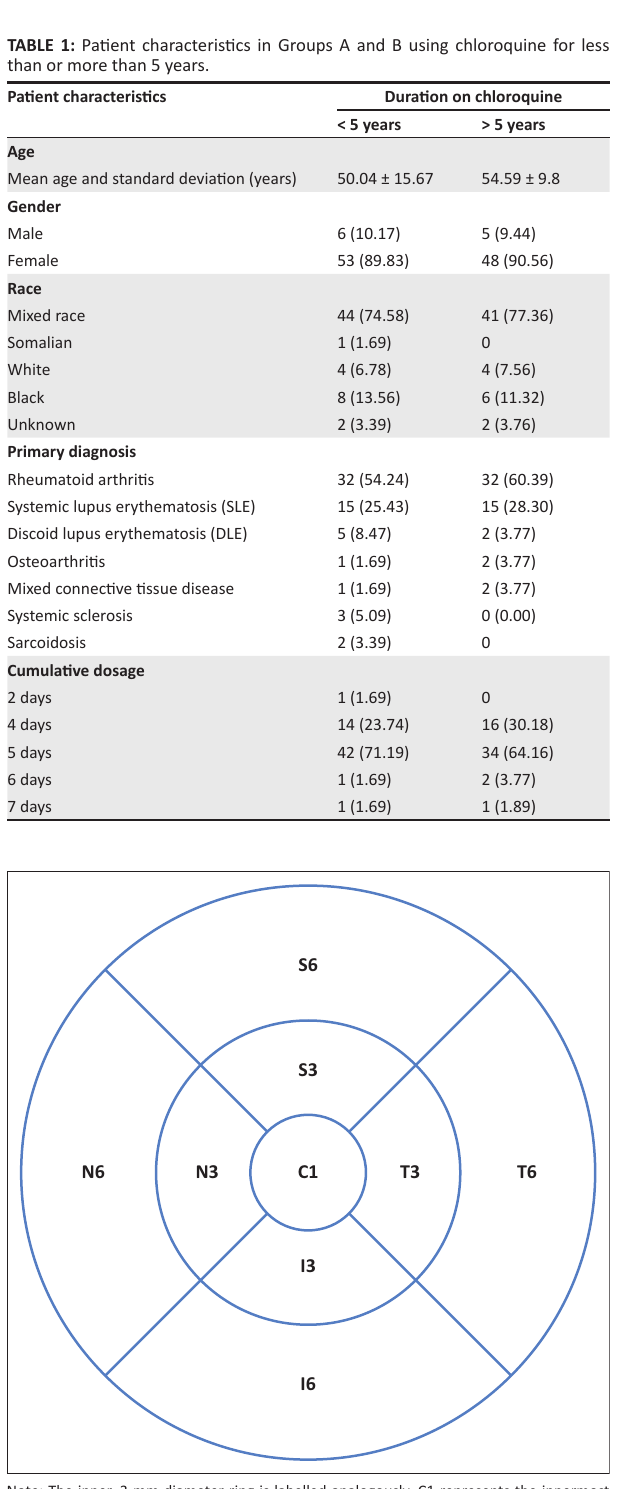
FIGURE 1: Macular map: the four quadrants of the outer, 6 mm diameter ring around the fovea are labelled S6, T6, I6 and N6 to represent the superior, temporal, inferior and nasal regions, respectively. 17